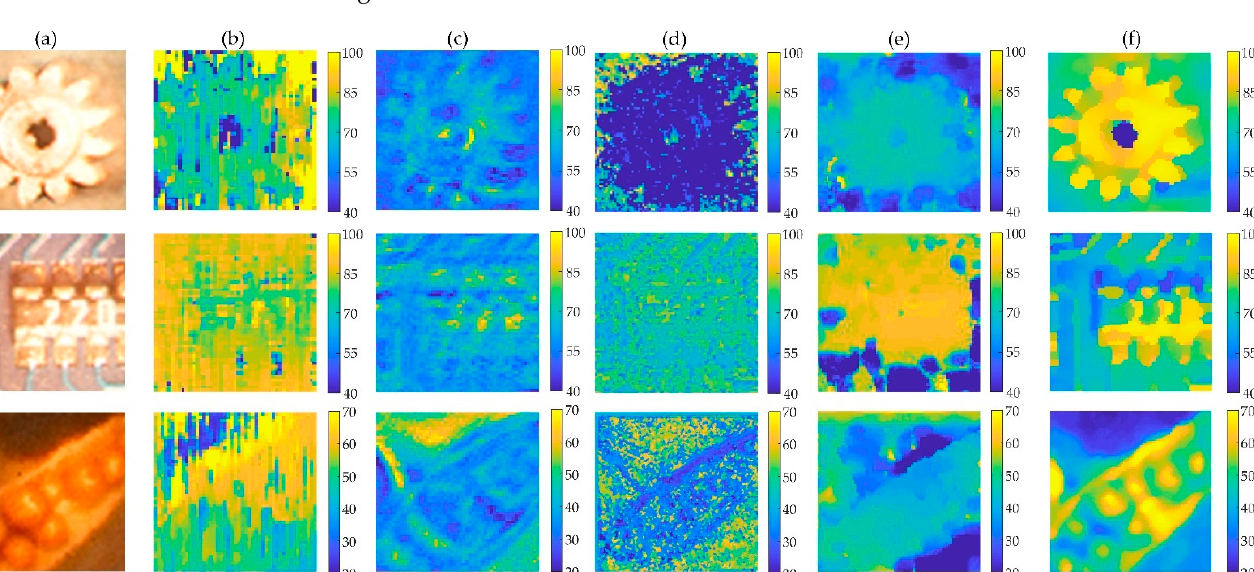
* Lower score represents better performance.